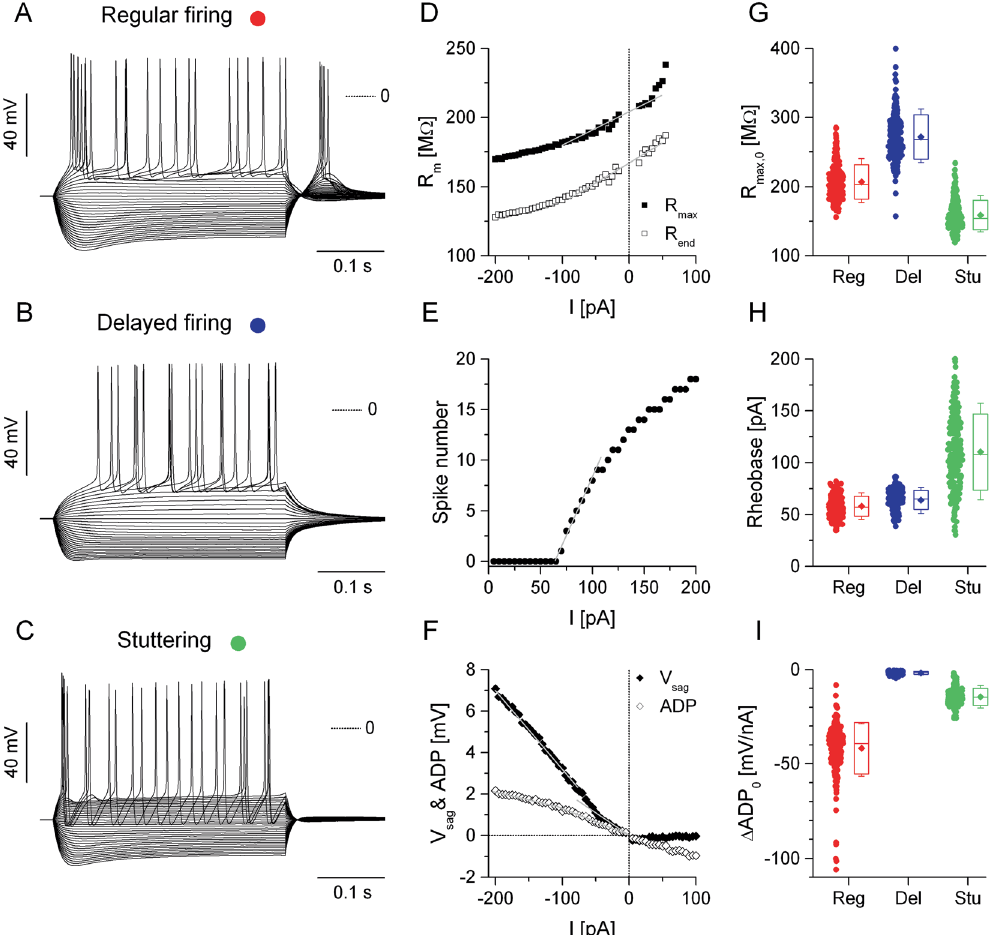
Figure 1. Three types of biophysically different model neurons produce distinctive voltage responses under current step stimulation. The voltage traces on the left are elicited using 400 ms current steps starting at − 200 pA and incremented by 5 pA ( A – C ). Middle panels illustrate various procedures to analyze the model neurons’ physiological properties. ( D ) Membrane resistance is plotted against the injected current. ( E ) Spike number vs. current relationship. ( F ) voltage sag and afterdepolarization. Rightmost panels show selected physiological parameters for the three types of model neurons, 200 instances in each group ( G – H ). ( G ) Input resistance (R max extrapolated to I = 0). ( H ) Rheobase. ( I ) The slope of the afterdepolarization function. Red, blue and green colors correspond to the regular firing, delayed firing and stuttering type model neurons as shown in ( A – C